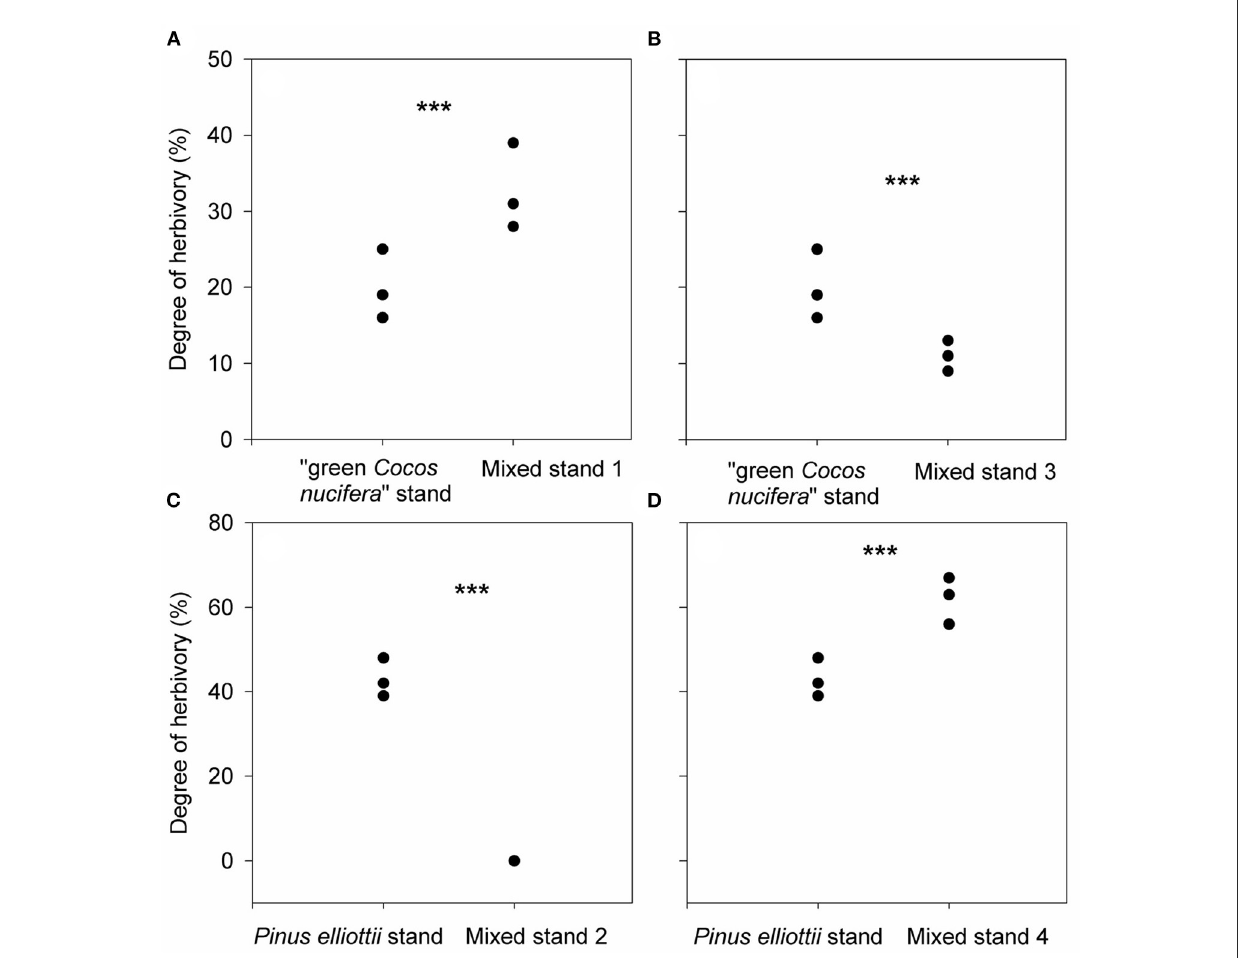
FIGURE2 Differences in degree of herbivory [the percentage of trees damaged by a pest (%)] of “green Cocos nucifera ” and Pinus elliottii between mixed stand 1 and the pure “green Cocos nucifera ” stand (A) , mixed stand 2 and the pure Pinus elliottii stand (C) , mixed stand 3 and the pure “green Cocos nucifera ” stand (B) , and mixed stand 4 and the pure Pinus elliottii stand (D) , respectively. ***indicates p < 0.05, results from our generalized linear mixed effect model with Poisson